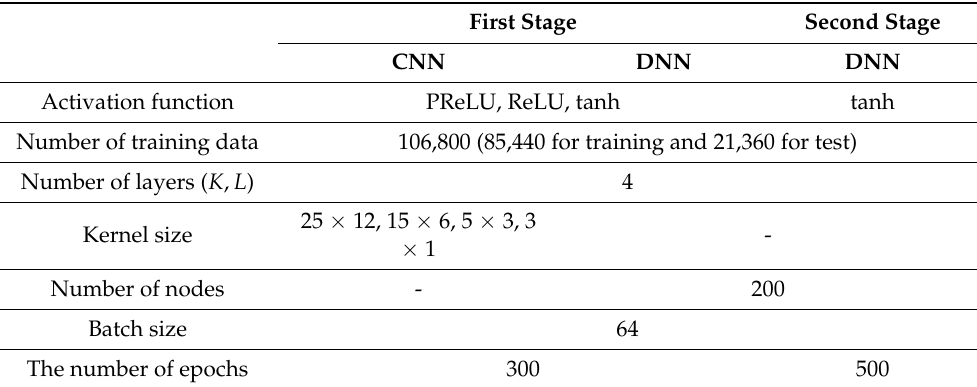
Table 1. Simulation settings for